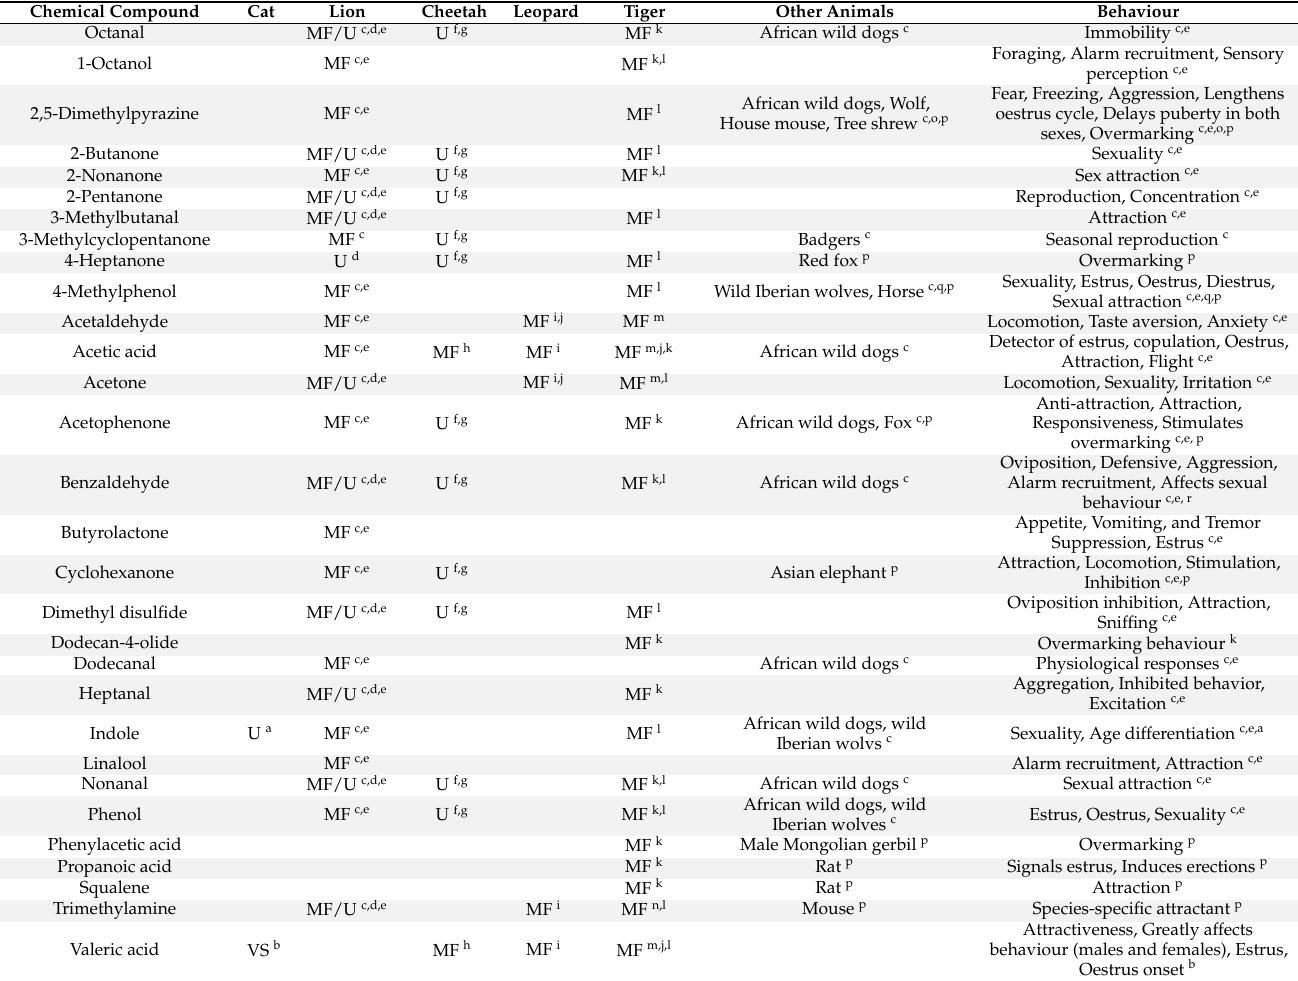
Table 1. Compounds identified in scent marks known to be involved in certain behaviours in several